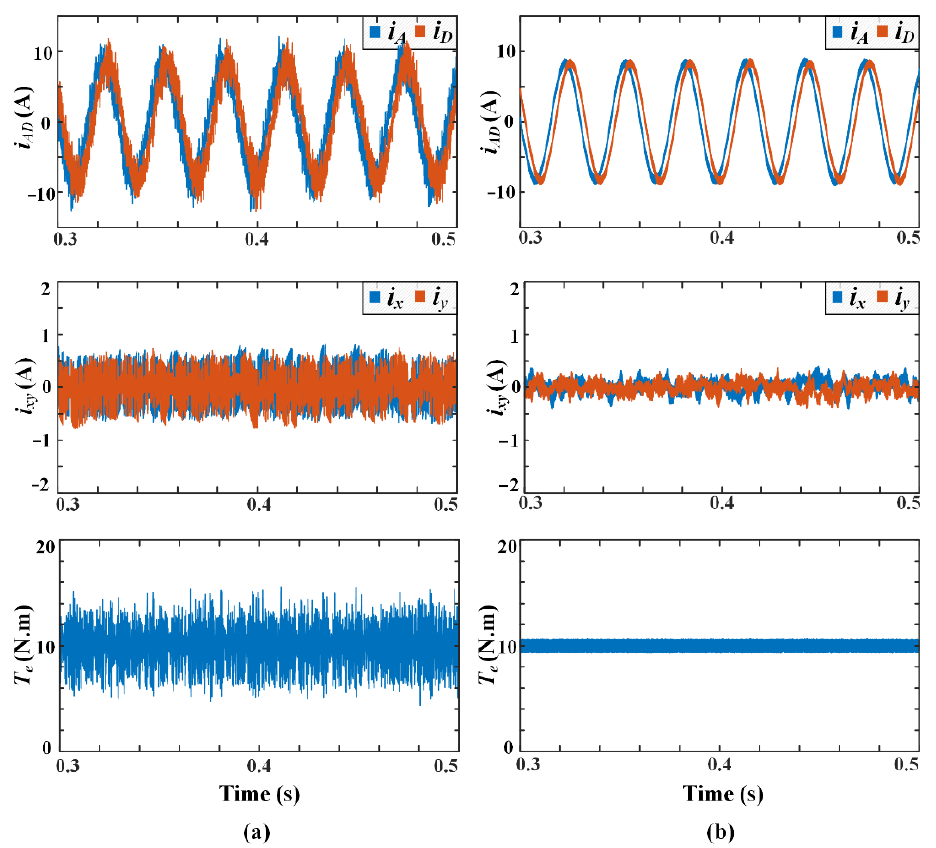
Figure 9. Steady-state performance with a load of 10 N.m. ( a ) Conventional VV-MPC; ( b ) proposed MVV-MPC.